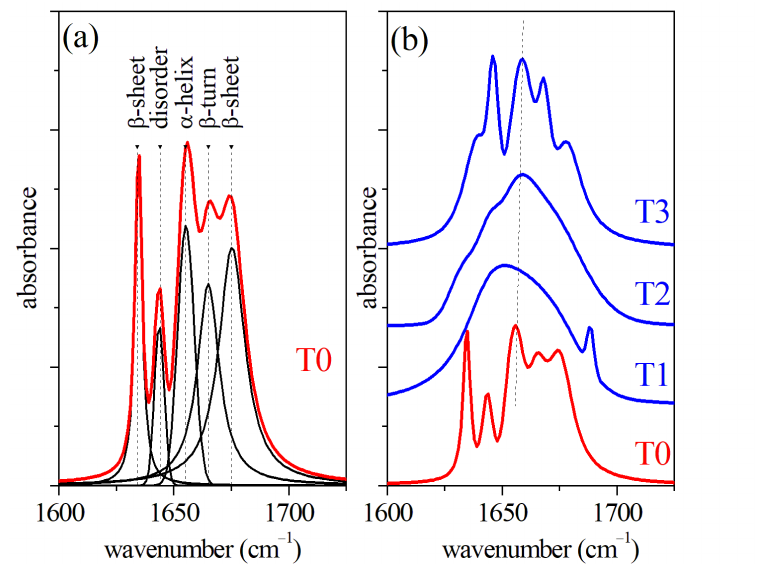
Figure 3. ( a ) FTIR spectrum of GCF collected before OTM (T0) and results of the deconvolution procedure; ( b ) comparison of FTIR spectra of GCF collected before OTM (T0) and after 2 days (T1), 7 days (T2), and 14 days (T3) of the OTM process. Table 2. Wavenumber position and relative peak areas of the main modes of the Amide I µ -FTIR spectral region of GCF and their assignment. The GCF were collected before starting the orthodontic process (T0 data) and after 2 days of treatment (T1 data), 7 days of treatment (T2 data), and 14 days of treatment (T3). The peak area percentage was evaluated by a fitting procedure, assuming the Amide I band area equal to 1. The values are shown as ‘mean ± standard deviation’ for each group. Bold values refer to Gaussian component, while normal font values refer to Lorentzian components. For comparison, the data reported in Ref. [16] are